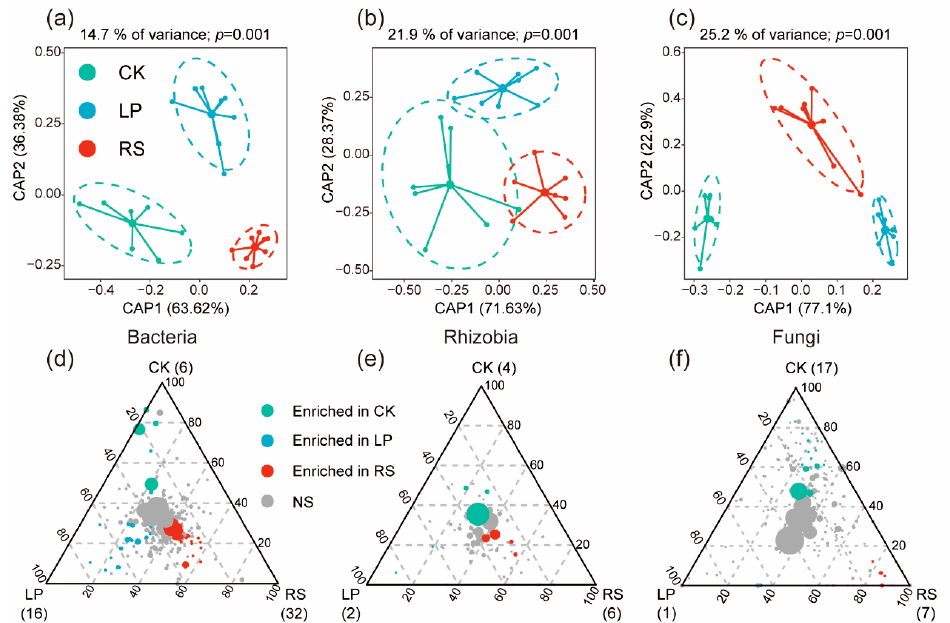
Figure 2. The effect of cover crops on the rhizosphere microbial community structure. Constrained principal coordinates analysis (CAP) plot showing bacterial ( a ), rhizobial ( b ), and fungal ( c ) community structure across treatments. Ternary plots show indicator operational taxonomic units (OTUs) of bacterial ( d ), rhizobial ( e ), and fungal ( f ) communities across treatments. Each dot indicates an OTU. The size of the dot indicates the average relative abundance of OTUs. The location of the dot indicates its relative abundance with respect to individual treatments. Green, blue, and red dots indicate OTUs notably enriched in CK, LP, and RS, respectively. The number in parentheses indicates the number of enriched OTUs.